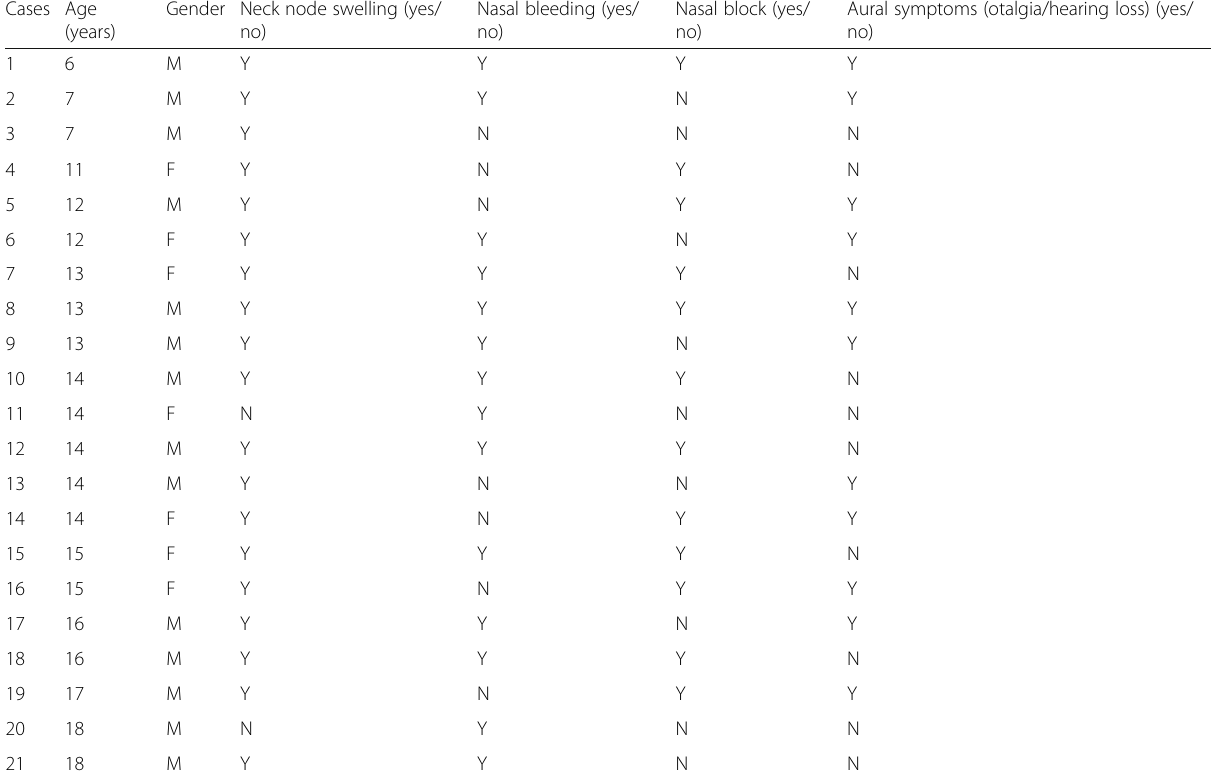
Table 2 Clinical profile of pediatric nasopharyngeal carcinoma Cases Age (years)